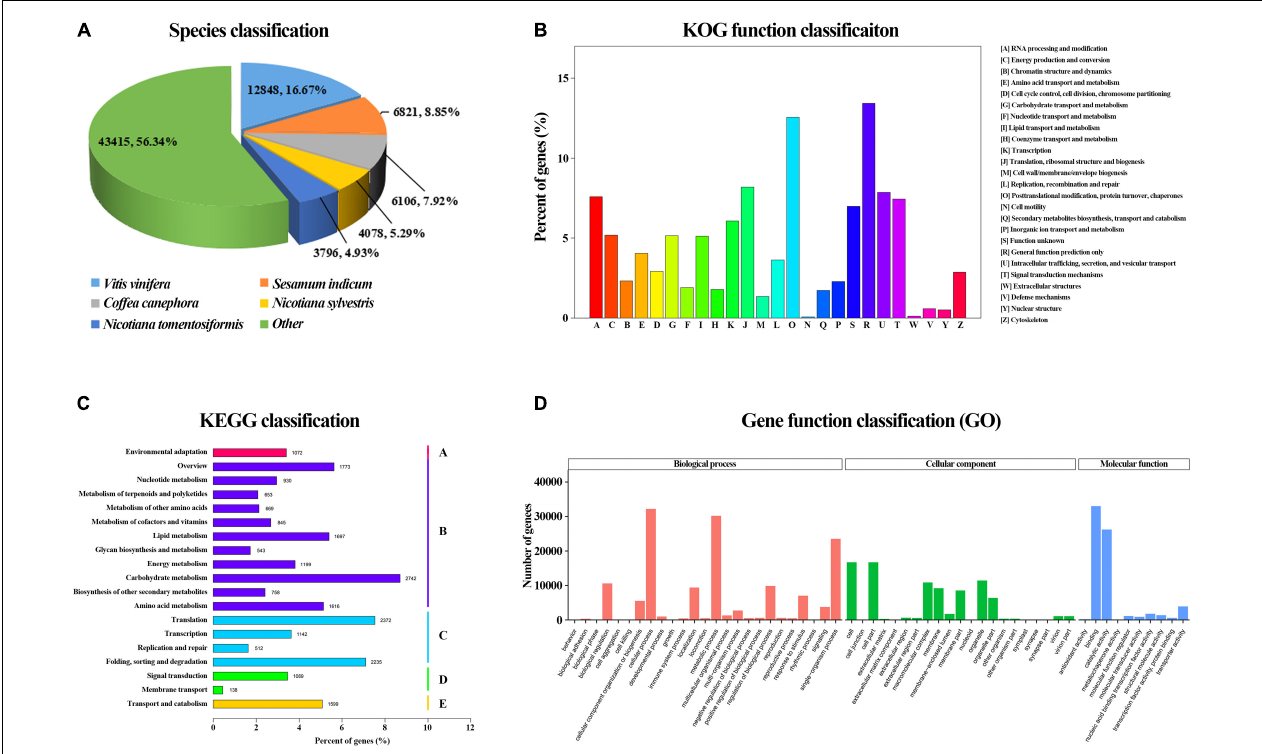
FIGURE 5 | Correlation and PLS-DA analysis based on flower color data of 123 accessions. (A) Species classification based on NR database. (B) KOG function classification. (C) Kyoto Encyclopedia of Genes and Genomes (KEGG) classification. (D) Gene function classification.